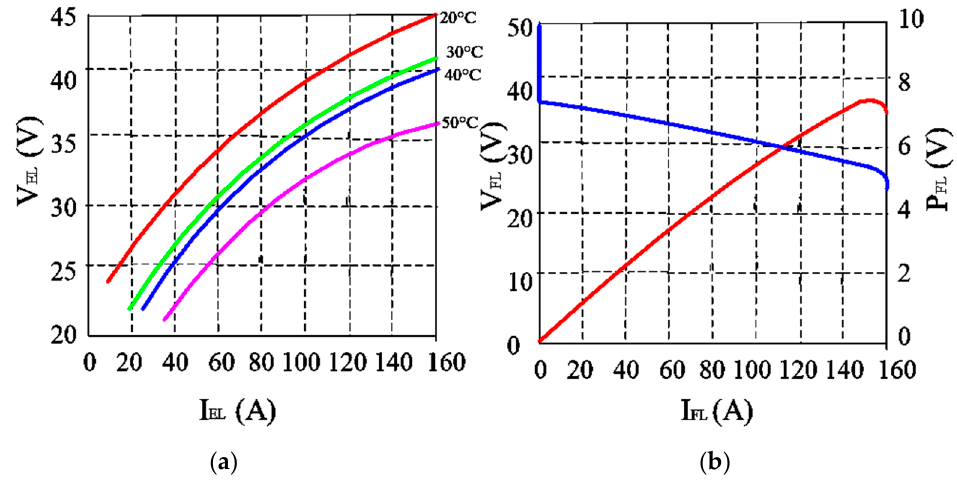
Figure 6. ( a ) Electrolytic characteristics and ( b ) fuel cell characteristics.